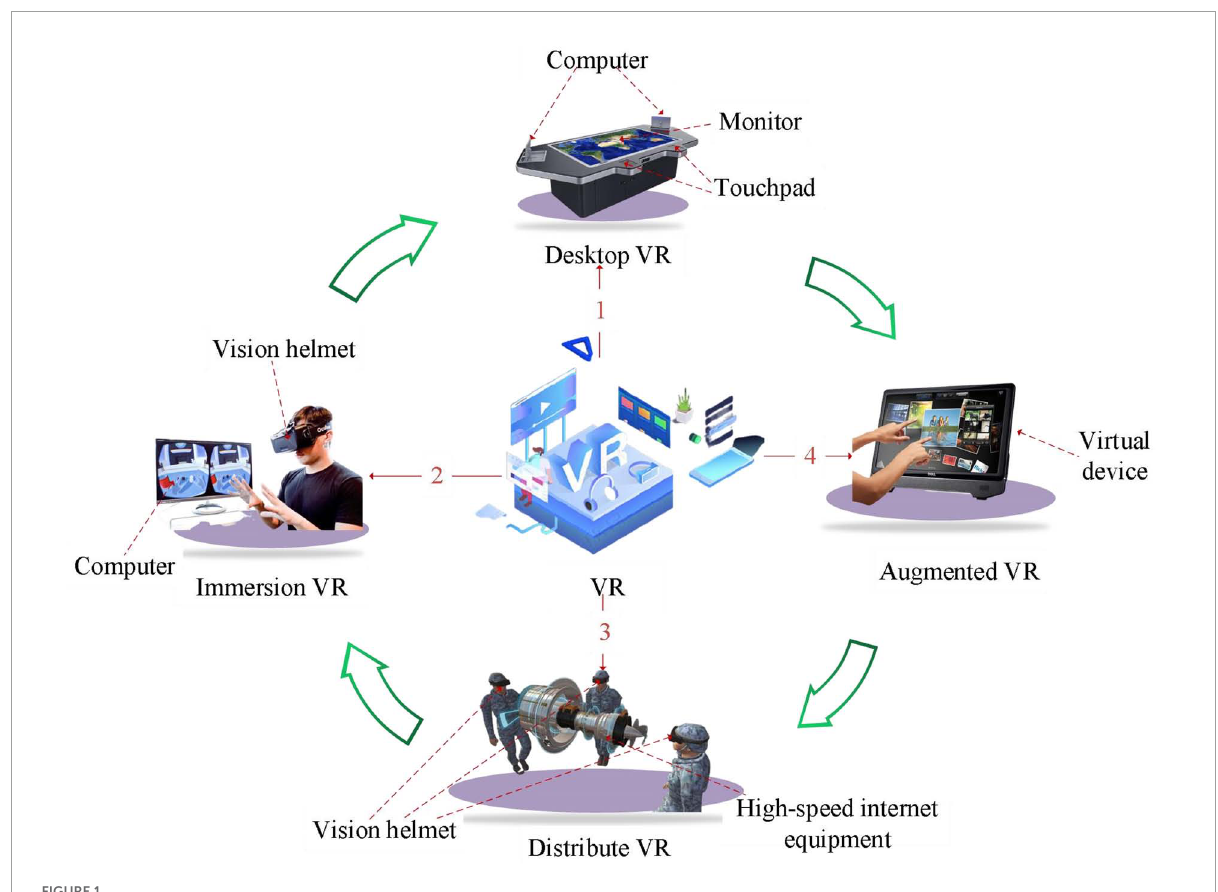
FIGURE1 VR adoption